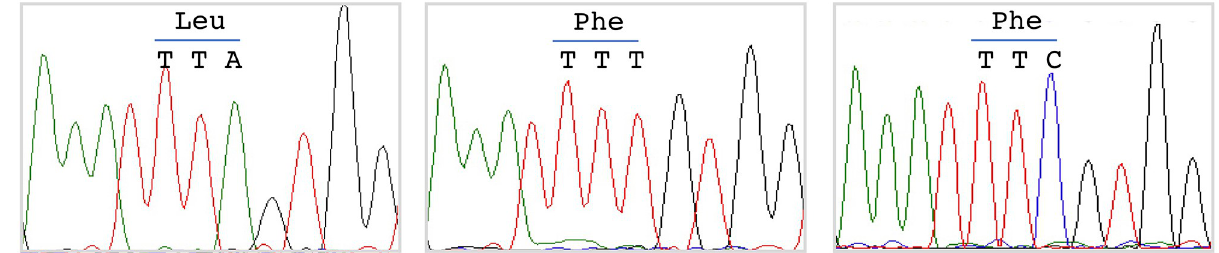
Fig 5. Snapshot of DNA sequence chromatograms showing three L1014 codons present in the VGSC of An . subpictus Form A.